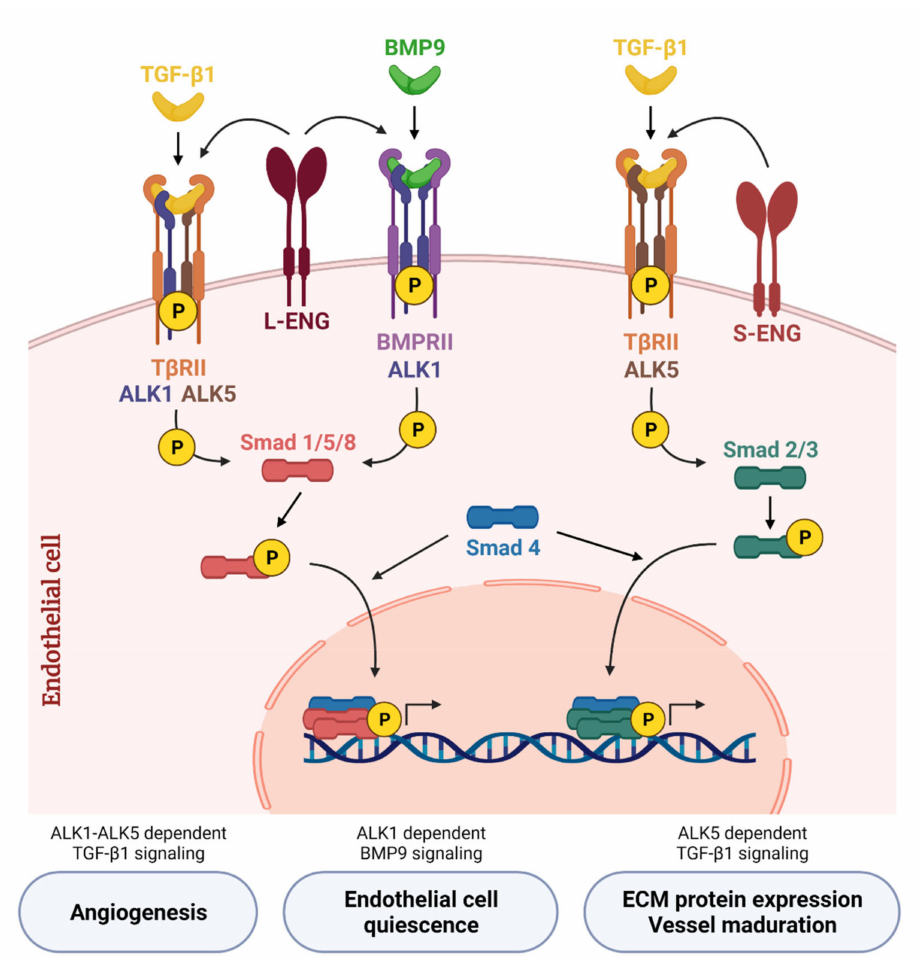
Figure 2. Canonical TGF- β /BMP signaling network in endothelial cells . TGF- β 1 binds to the transforming growth factor- β receptor type II (T β RII) that phosphorylates the type I receptor (T β RI). In endothelial cells, TGF- β 1 induces Smad2/3 phosphorylation through T β RI activin receptor-like kinase 5 (ALK5) and is potentiated by S-Endoglin (S-ENG) ( right part of the scheme ). On the other hand, TGF- β 1 induces Smad1/5/8 phosphorylation through T β RI activin receptor-like kinase 1 (ALK1)—only in the presence of ALK5—and is potentiated by L-Endoglin (L-ENG) ( left part ). BMP9, the high affinity ligand for ALK1, transduces signals through ALK1 and bone morphogenetic protein receptor II (BMPRII). BMP9